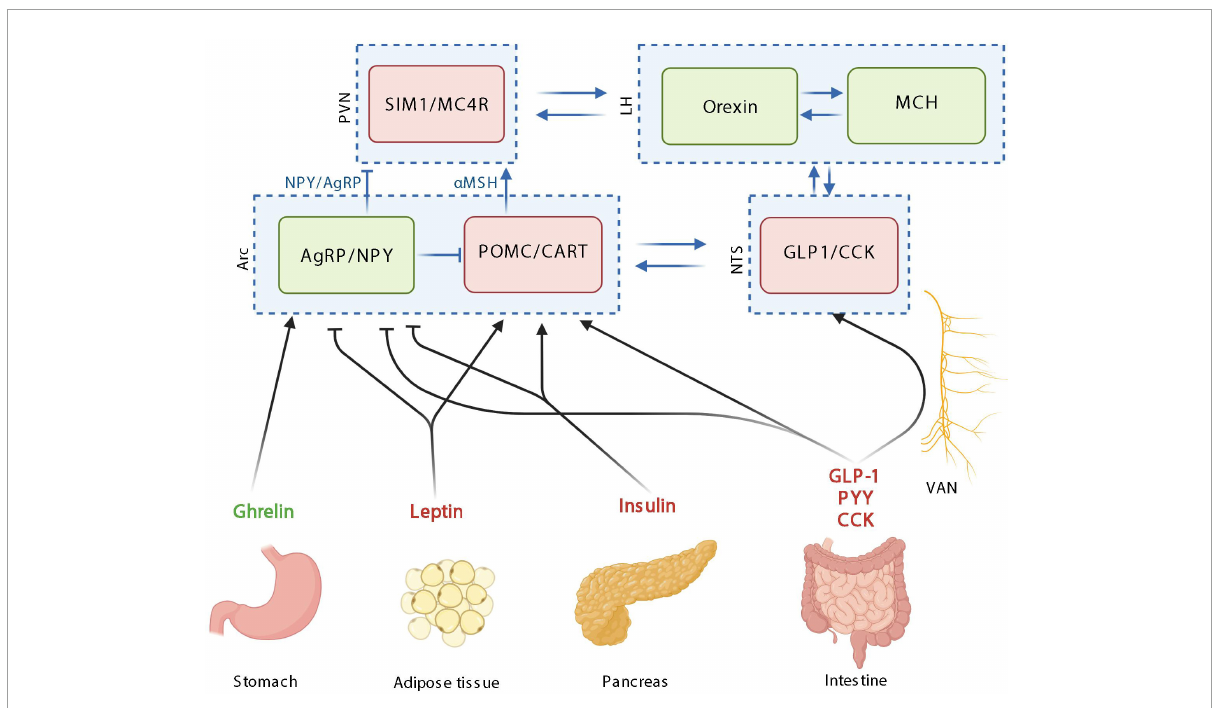
FIGURE1 The homeostatic control of food intake upon peripheric signals. Orexigenic hormones or neurotransmitters are in green; anorexigenic hormones or neurotransmitters are in red. PVN: paraventricular nucleus; SIM1, single–minded family BHLH transcription factor 1; LH, lateral hypothalamus; MCH, melanin-concentrating hormone; Arc, arcuate nucleus; AgRP, agouti-related protein; NPY, neuropeptide Y; POMC, pro-opiomelanocortin; CART, cocaine-amphetamine-related transcript; NTS, nucleus tractus solitarus; VAN, vagal afferent nerves; CCK, cholecystokinin; GLP-1, glucagon-like peptide 1; PYY, peptide YY; MC4R, Melanocortin 4 receptor. Created with